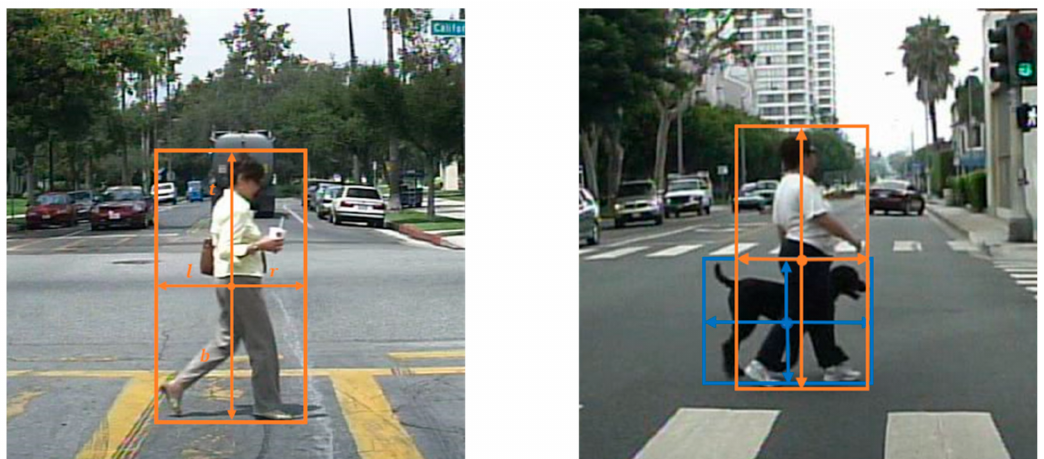
Figure 2. The left image shows single-objective regression, (l, t, r, b) means the distance from the center point to the bounding box. The right plot shows multi-objective regression. When points fall into the overlapping area, it might be difficult to determine which box should